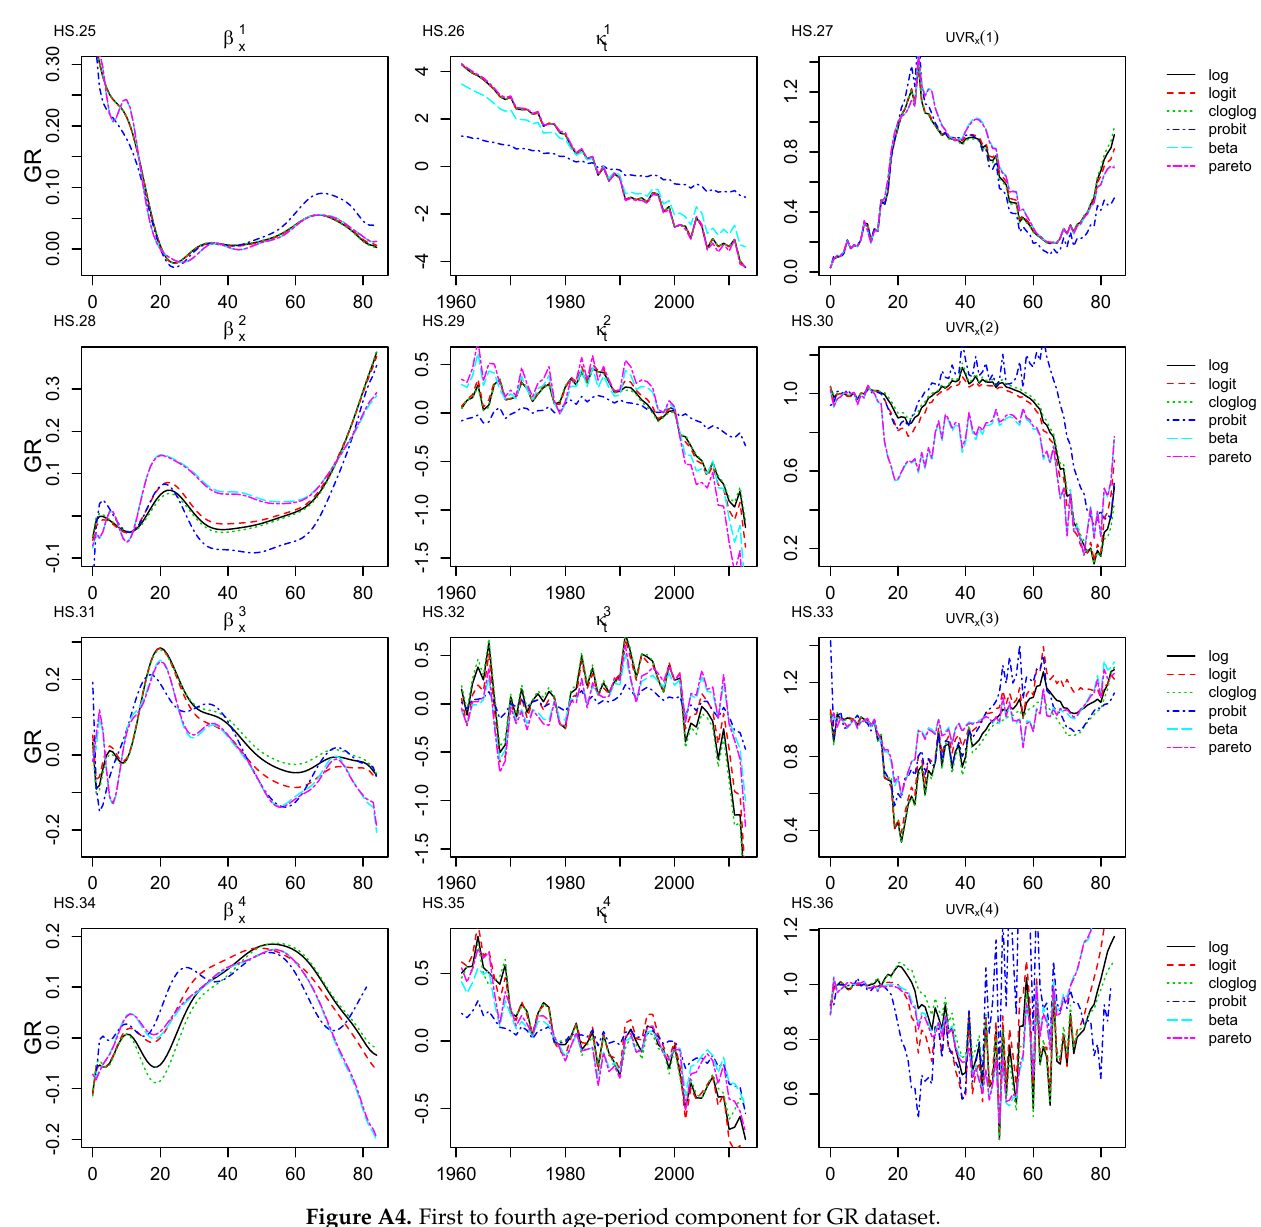
Figure A4. First to fourth age-period component for GR dataset.